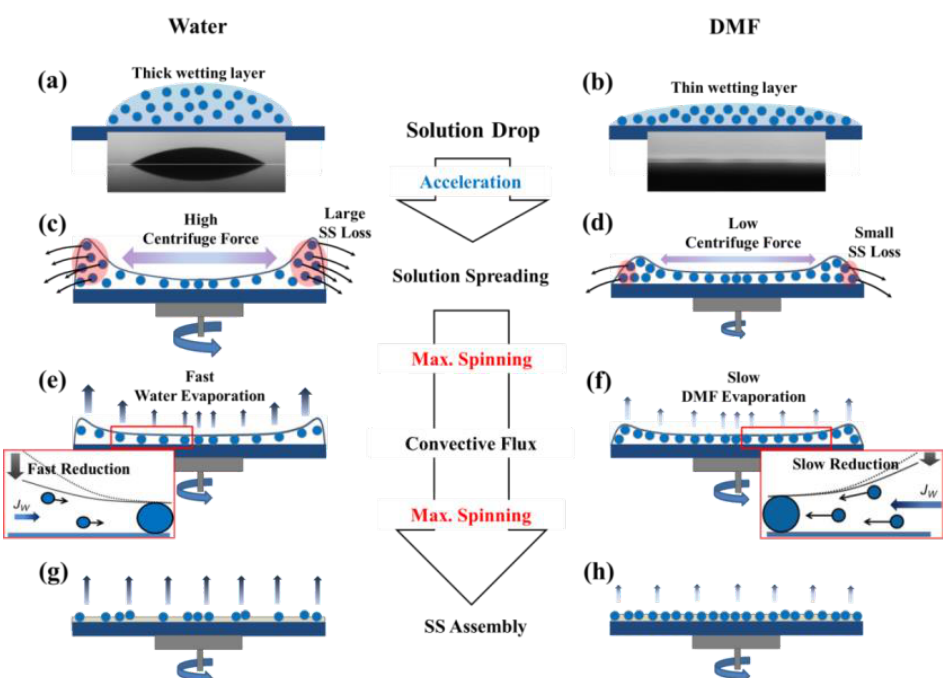
Figure 1. Schematic illustration to compare N, N-dimethyl-formamide (DMF) and water for spin-coating application.